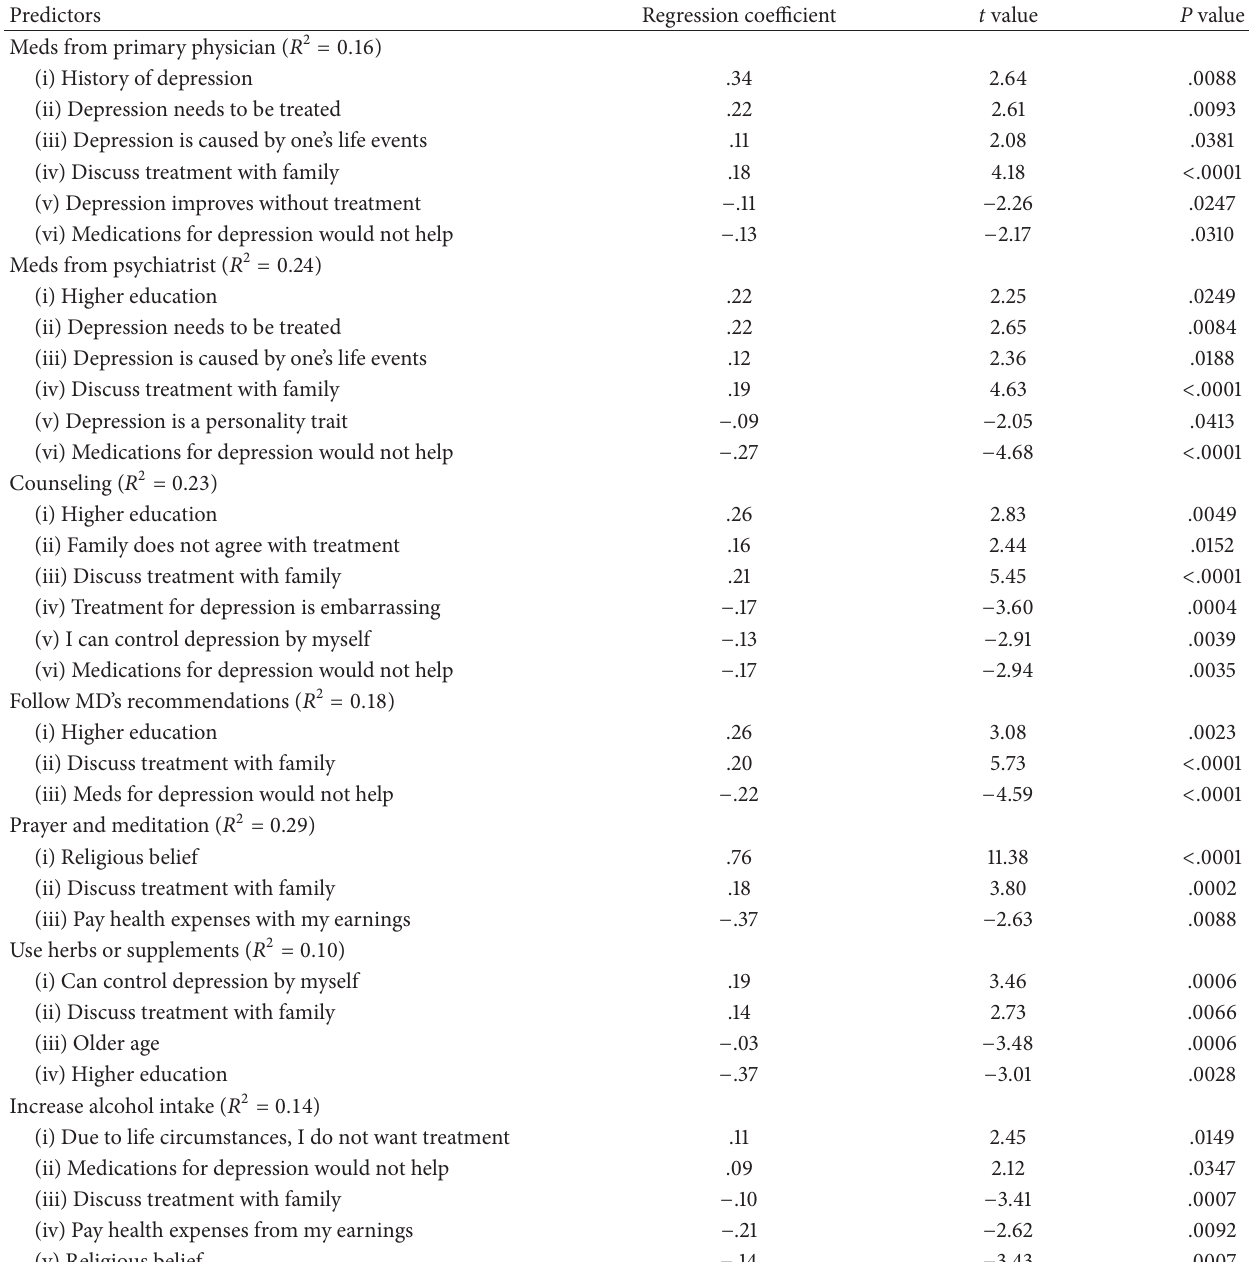
Table 5: Multiple linear regression analyses on the treatment